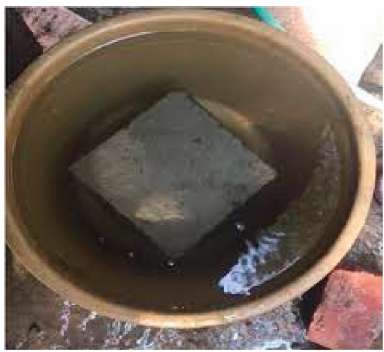
Figure 6: Specimen immersed in H